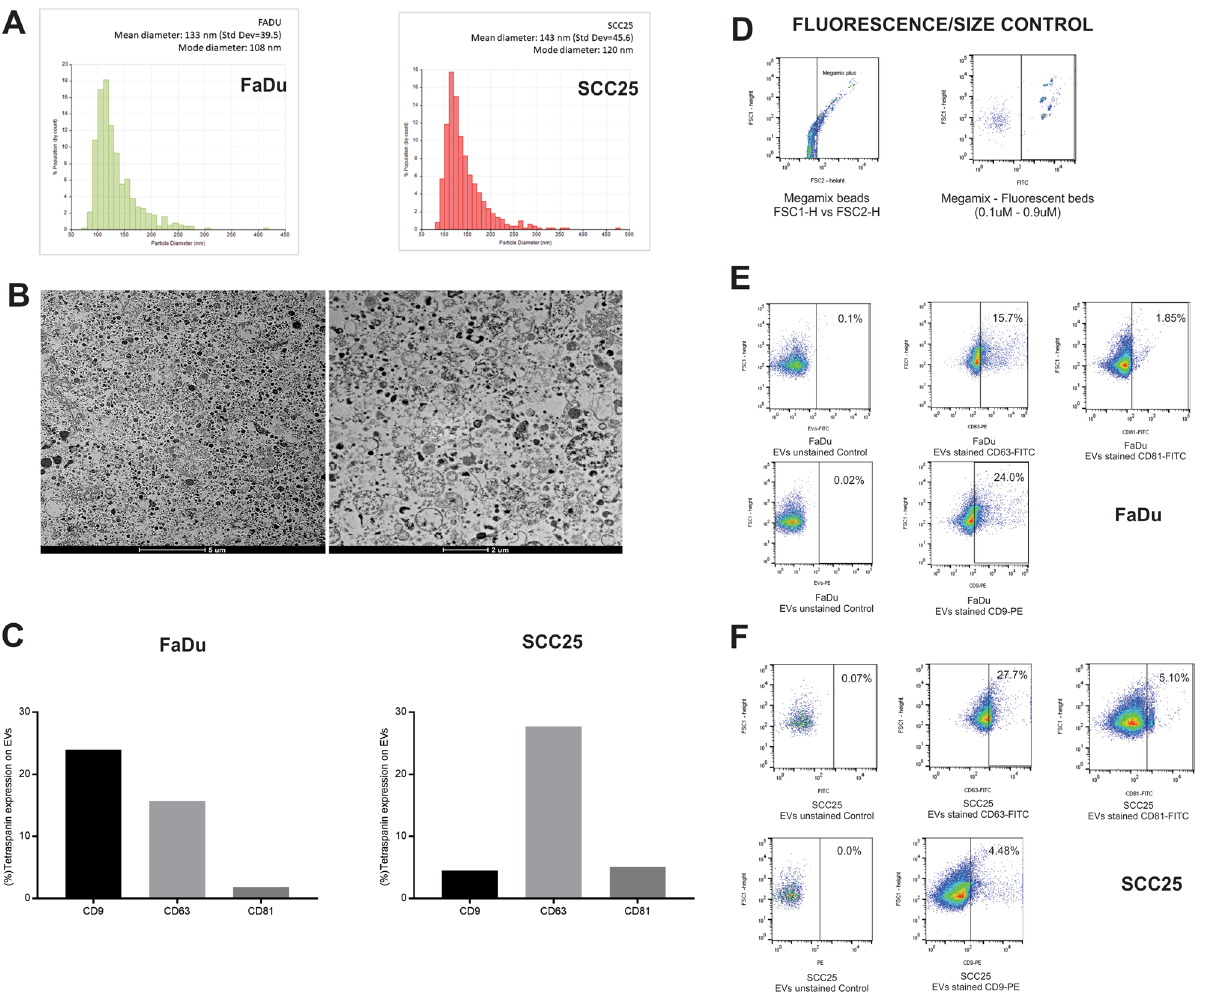
Figure 1. EVs characterization by size, imaging and tetraspanin expression. ( A ) Size distribution of EVs in SCC25 and FaDu culture medium. EV sizes were plotted over calibration particles diameters; ( B ) Representative images of transmission electron microscopy of EVs isolated from cell culture medium at × 2100 and × 3500 magnification, the selected images were obtained from FaDu culture medium but identical results were obtained for SCC25; ( C ) First graph displays the percentage of tetraspanin expression (CD9, CD63 and CD81) by EVs derived from FaDu cell lines and second graph displays the percentage of tetraspanin expression (CD9, CD63 and CD81) by EVs derived from SSC25 cell lines; ( D ) Flow cytometry control of fluorescence and size determination using Megamix-Plus FSC fluorescent particles with different sizes (0.1–0.9 µM); ( E ) Representative dot plot graphs displaying fow cytometry analysis of tetraspanin (CD9, CD63 and CD81) expression by EVs derived from FaDu cell line; ( F ) Representative dot plot graphs displaying fow cytometry analysis of tetraspanin expression by EVs derived from SCC25 cell